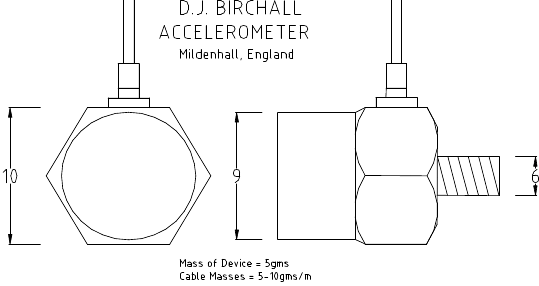
Fig. 2. Miniature piezo-electric accelerometer (all dimensions in mm).